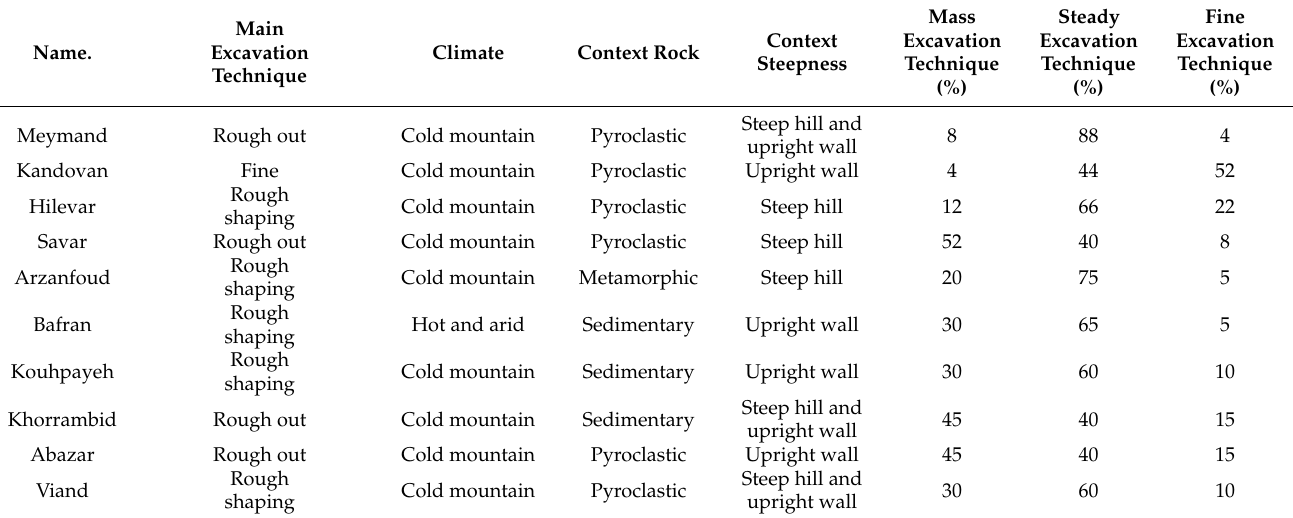
Table 1. Technical characteristics of well-known Iranian rock-cut residential complexes.